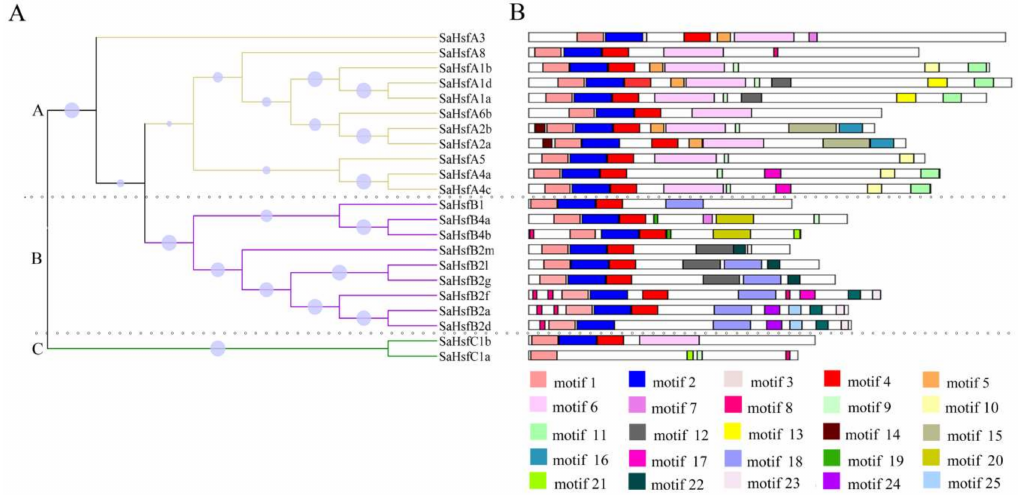
Figure 3. Phylogenetic relationships and motif compositions of the Hsf family in S. alfredii : ( A ) multiple alignment of Hsf proteins from S. alfredii was performed using MEGA 6.0 by the neighbor-joining (NJ) method with 1000 bootstrap replicates, which represented by circles; ( B ) schematic representation of each of the conserved motifs in the Hsf proteins was identified by the MEME online tool. Different motifs are represented by different colored boxes. The dashed lines are used to cluster and distinguish the genes into the A, B, and C